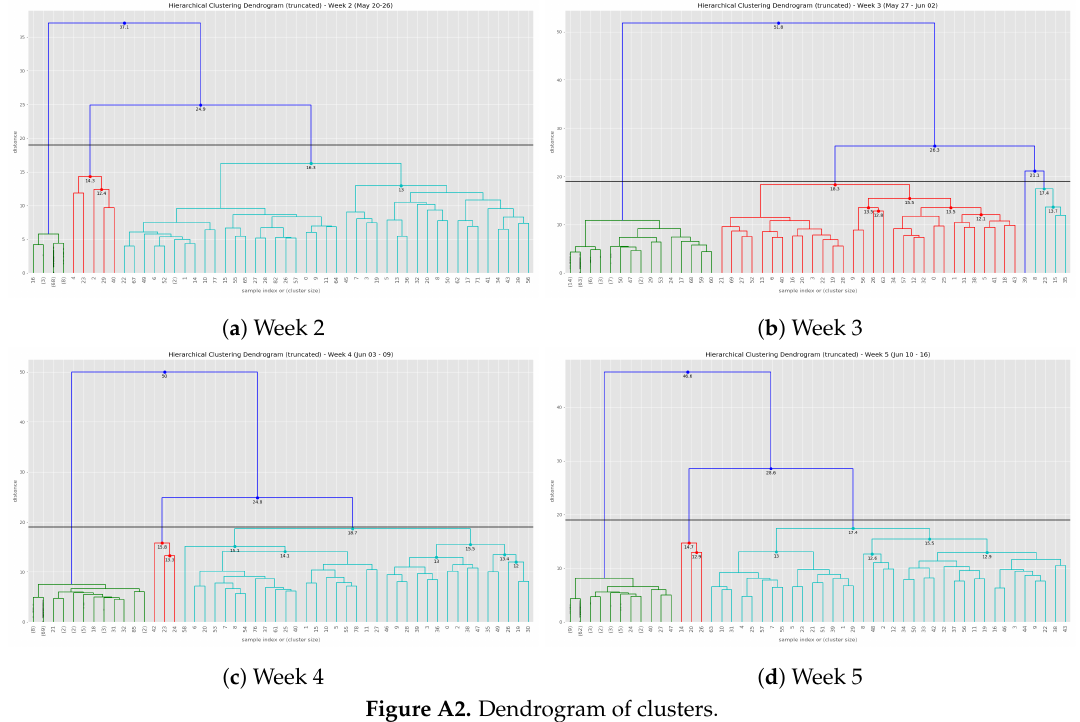
Figure A2. Dendrogram of clusters.